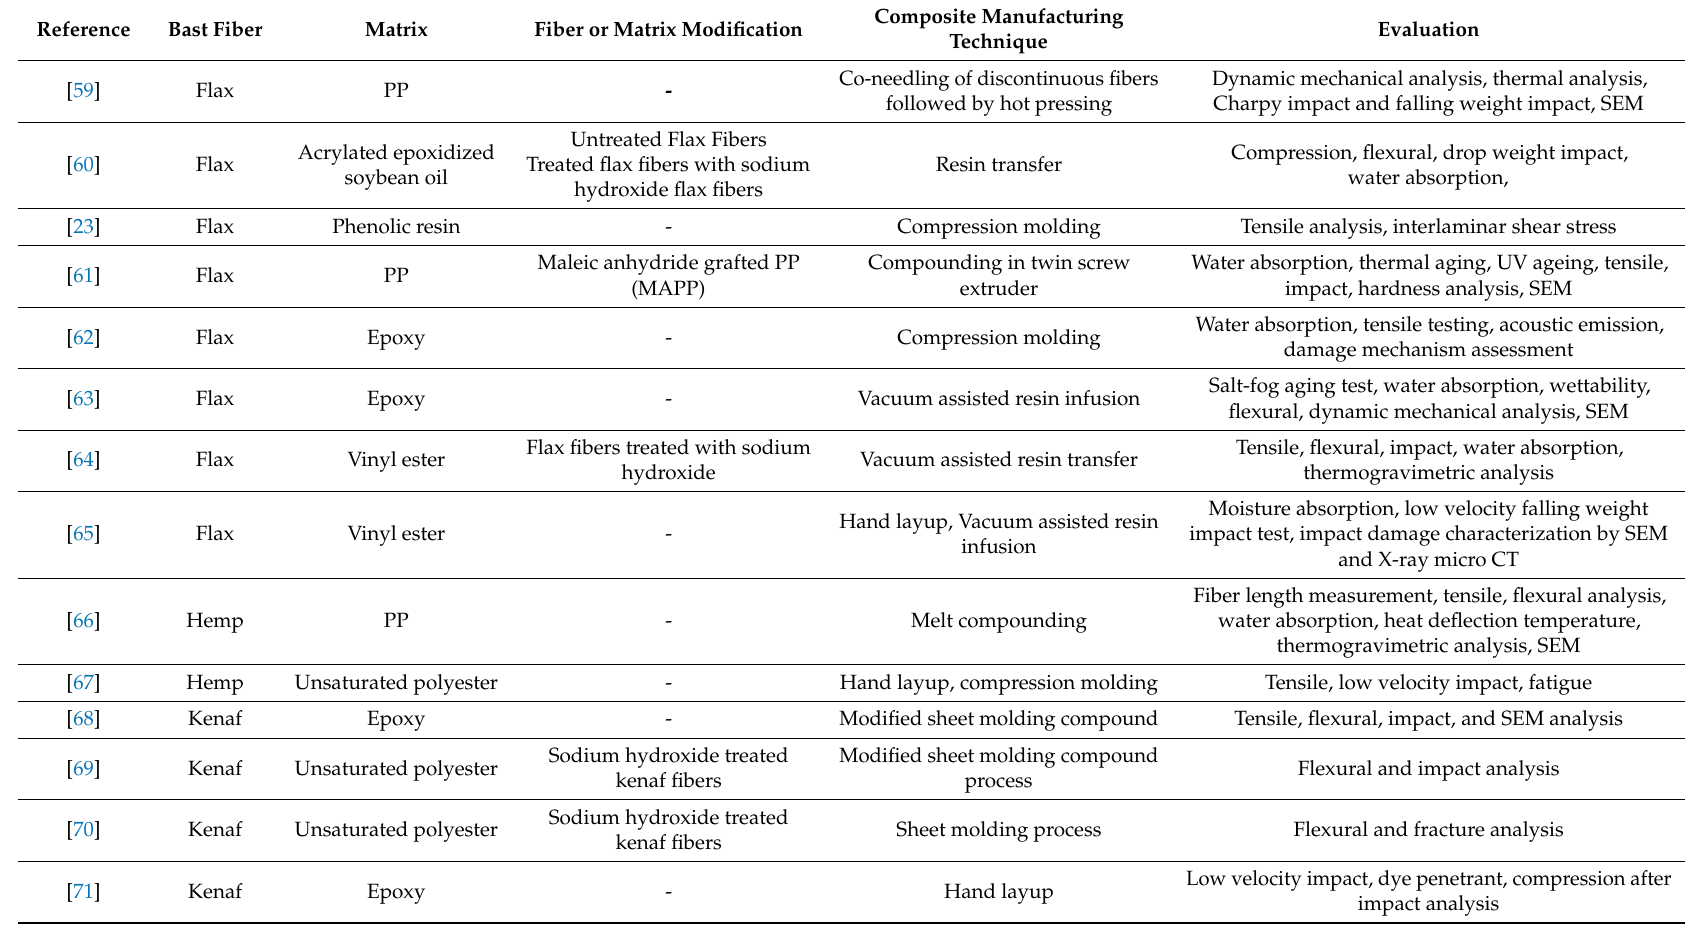
Table 4. Research contributions about hybrid bast / glass fiber